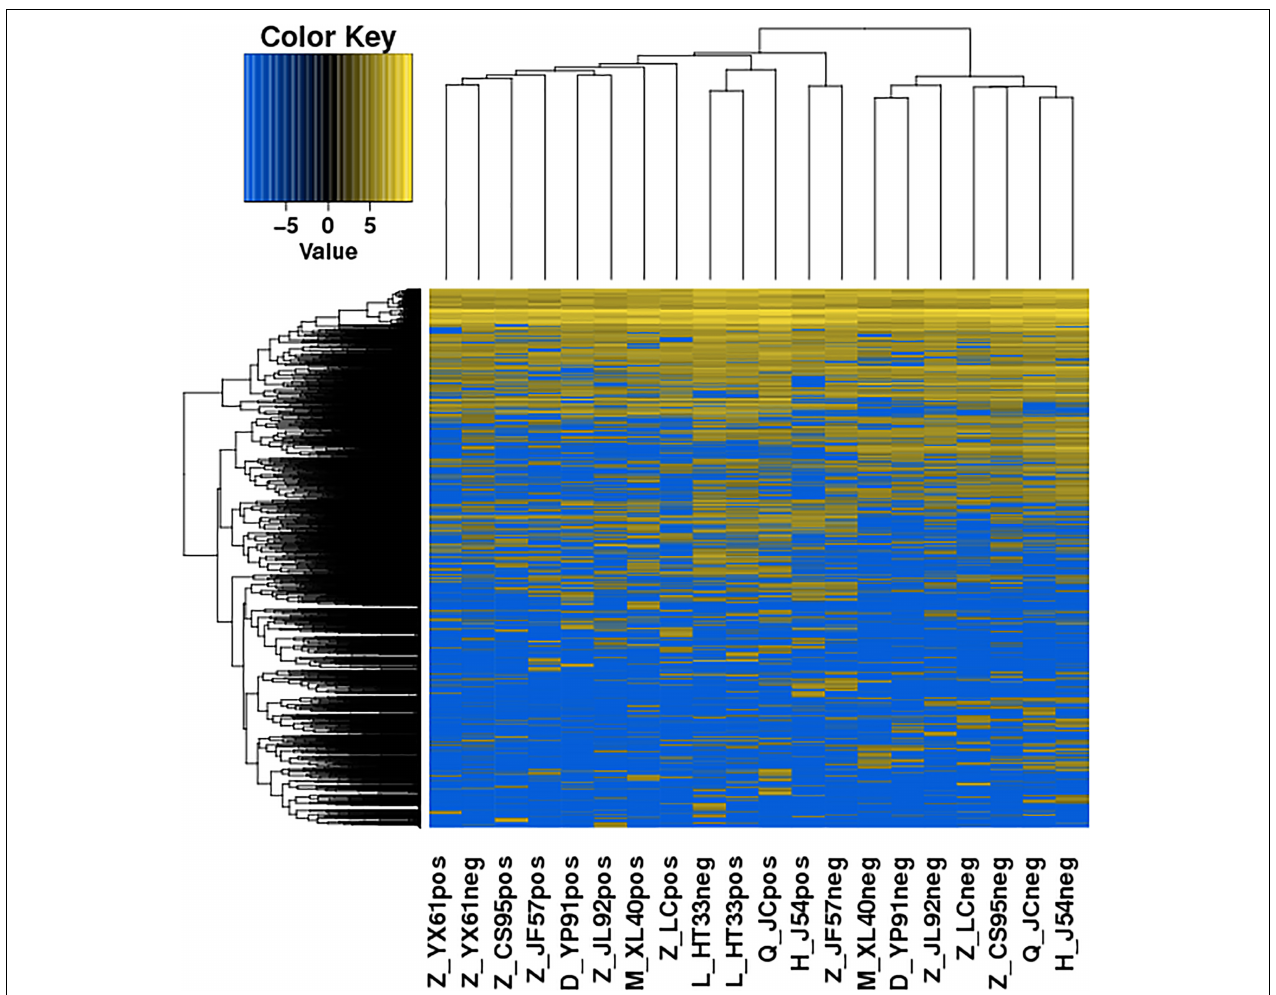
FIGURE 6 | Heatmaps of DE circRNA: According to the expression level of differentially expressed circRNA in each sample, the clustering results of the sample were obtained. In the figure, the various colors represent different expression levels. Blue color indicates the lower expression level, and yellow color indicates the higher expression